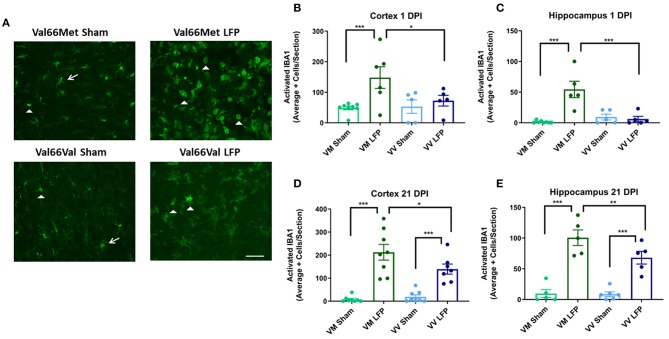
Repeated mild LFP injury causes an increase in ionized calcium binding adaptor molecule 1 (IBA1) positive cells in the brains of injured Val66Met mice compared to injured Val66Val mice at 1 DPI. (A) Representative images of cortical sections at 1 DPI stained with IBA1. White arrows indicate resting microglia, white arrowheads indicate activated microglia. Scale bars = 100 μm. (B–E) Quantification of the average number of IBA1+ positive cells, broken down into activated and resting categories by morphology, per cortex and hippocampus ± SEM. *p < 0.05, **p < 0.01, ***p < 0.001, ANOVA Fisher's PLSD post-hoc test relative to indicated groups, n =5–8.